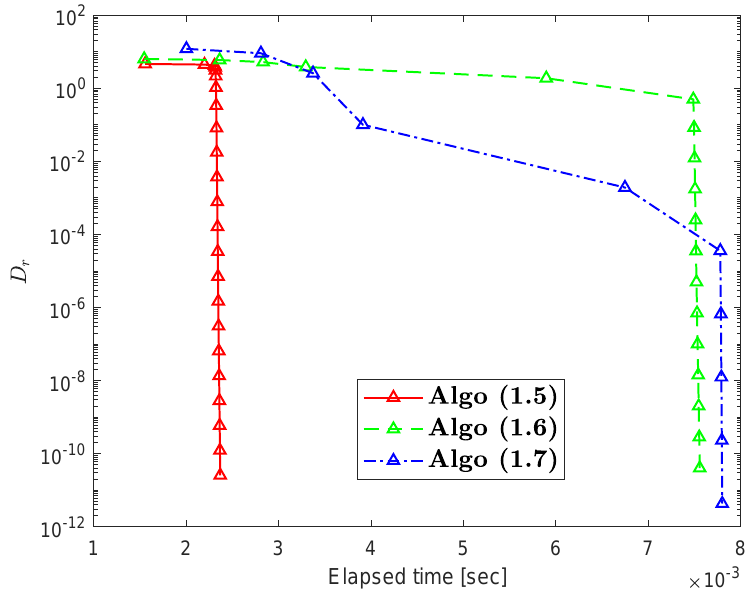
Figure 4. A graphical comparison of Algorithms (5)–(7), where z 1 = 3.82.